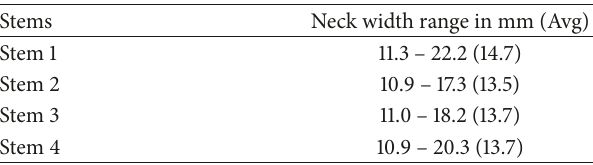
Table 2: Neck width range for four stems investigated in this study.